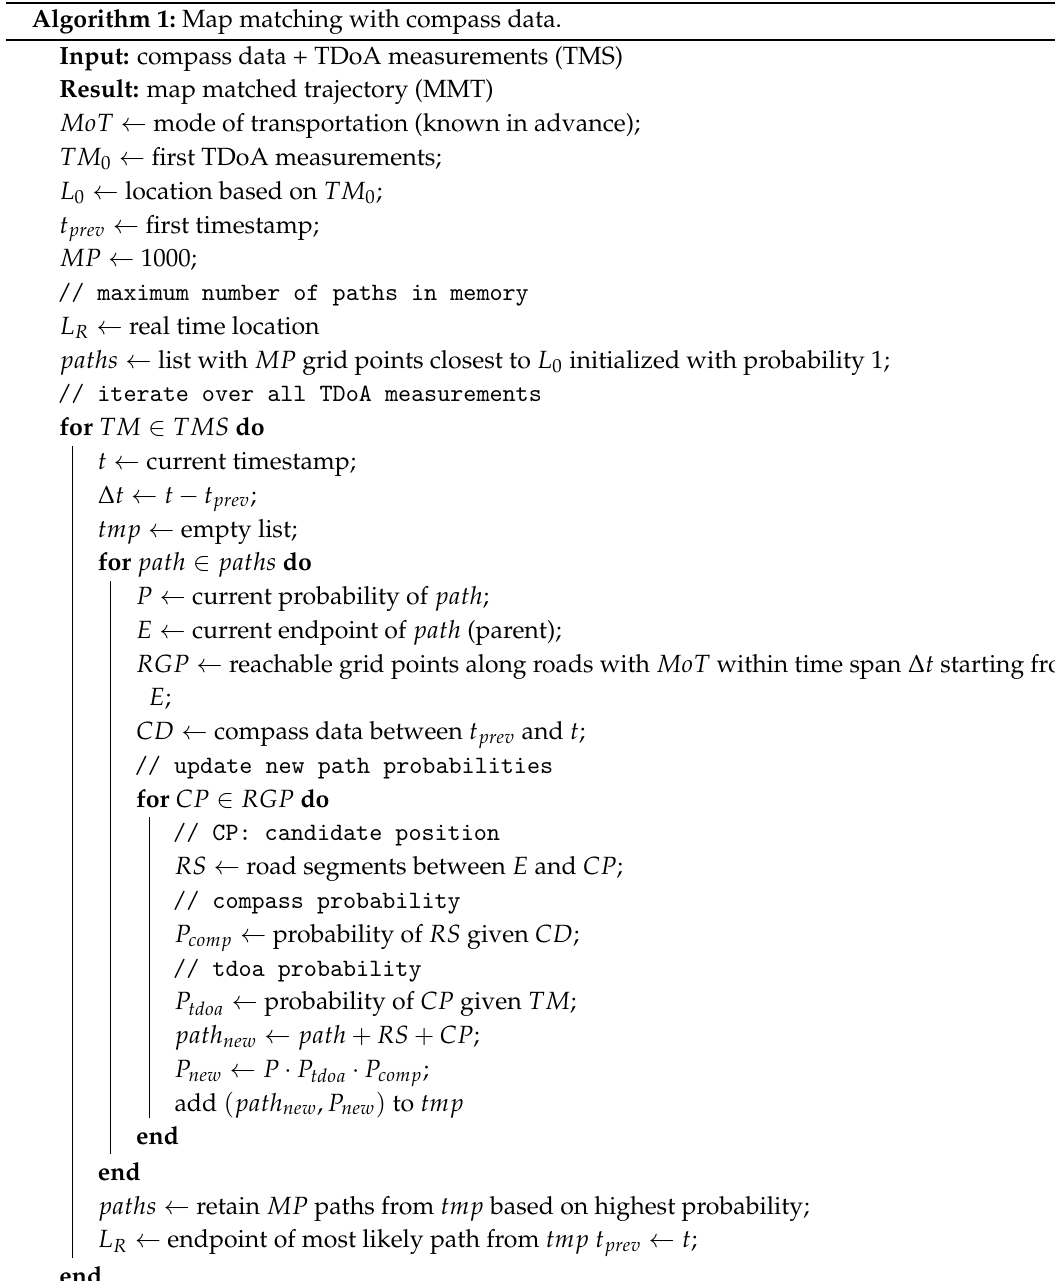
Algorithm 1: Map matching with compass